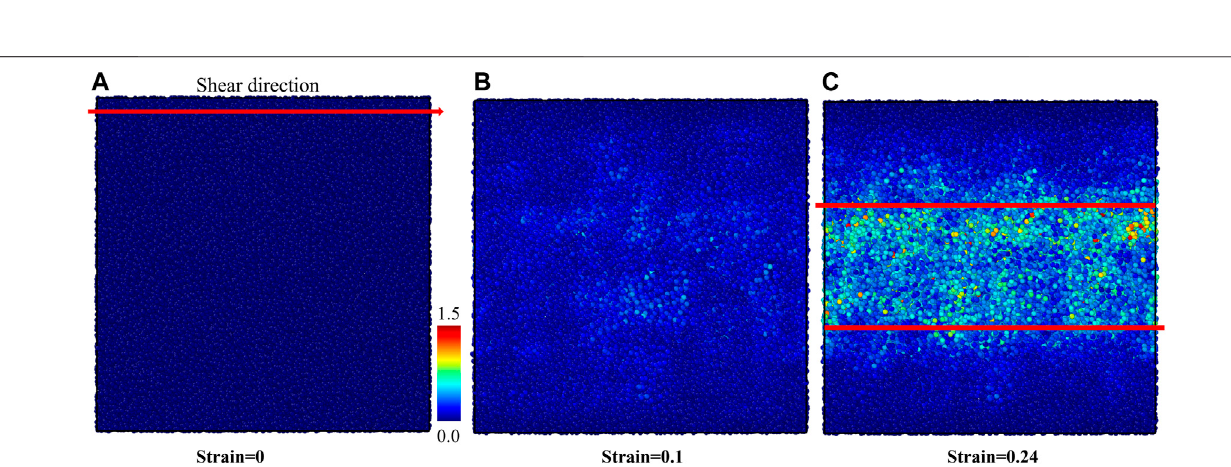
Frontiers in Materials |